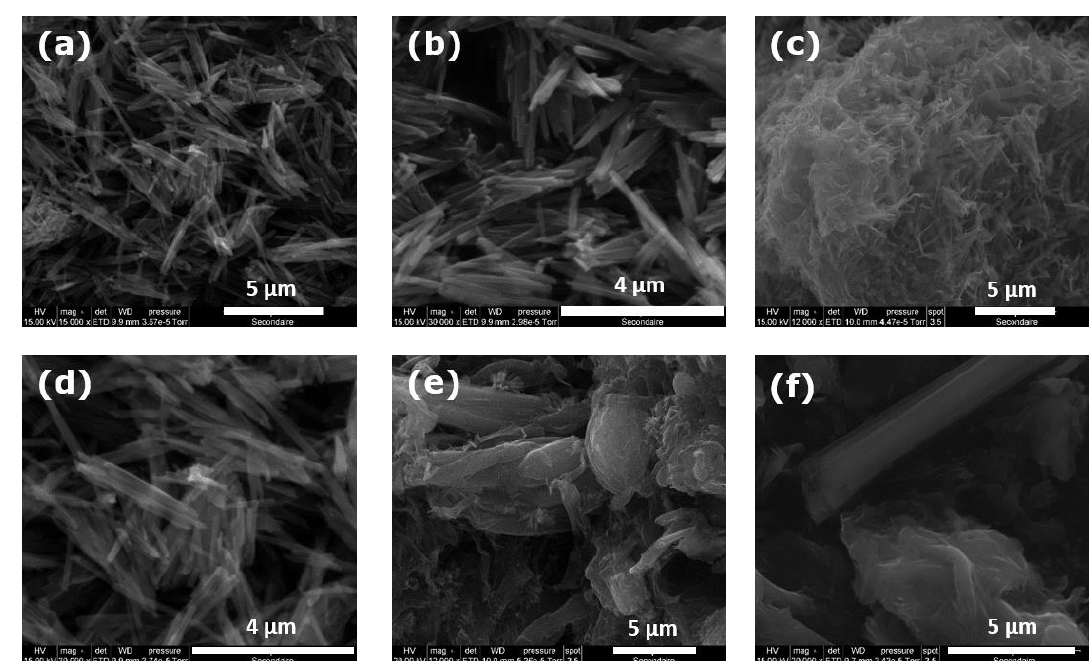
Figure 3. SEM micrographs of hybrid hexadecylamine-vanadium oxide materials prepared under the synthesis conditions detailed in Table 2 (each letter indicating a given panel corresponds to that in Table 2).